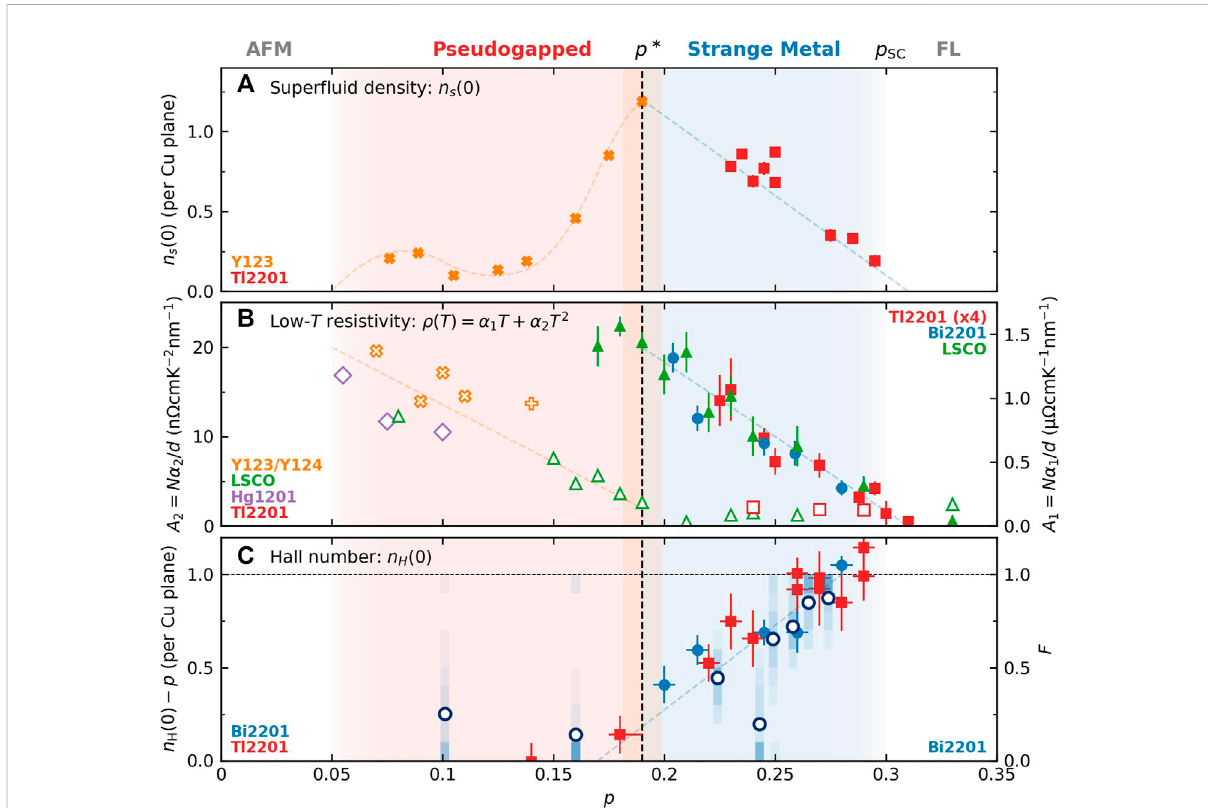
FIGURE 1 Correlations between super fl uid density n s (0) and various transport properties of hole-doped cuprates. (A) Evolution of n s (0) (per Cu) with doping p inY123(orange crosses) and Tl2201(redsquares)obtained frommeasurementsof thezero-temperaturein-planepenetration depth λ ab (0) (summarized in [33, 63]. In order to deduce n s (0) in Y123, we used m * values obtained from high- fi eld quantum oscillation studies over the doping range 0.10 ≤ p ≤ 0.15 [64] and extrapolated to p * = 0.19 assuming that n s (0) approaches 1 + p * there. For a description of how n s (0) is obtained forTl2201,pleaserefertoAppendixAin[33].AllparametersusedinthesedeterminationsarelistedintheSupplementaryMaterial.Notethatthepeak in n s (0)atthepseudogapendpoint p *(verticaldashedline)delineatesthepseudogapped(PG)regime,shadedinorange, fromthestrangemetal (SM) regime, shaded in blue. (B) p -dependence of A 1 = N α 1 / d (right axis, solid points) and A 2 = N α 2 / d (left axis, open points), where d is the c -axis lattice constant, N is the number of CuO 2 planes per unit cell and α 1 , α 2 are coef fi cients of the low- T zero- fi eld resistivity ρ ( T ) = α 1 T + α 2 T 2 . Open crosses (plusses)indicatedataforY123(Y124),respectively.SeeSupplementaryMaterialfortheprecisevaluesandreferencesrelatedtothesedatapoints. (C) Comparison of n H (0) − p , the p -dependence of the as-measured low- T Hall carrier number of Tl2201 and Bi2201 minus its corresponding p value (left axis, closed points [15]) and F , the fractional fi lling of the superconducting gap as measured recently by STM on Bi2201 (right axis, open points [36]). Shaded columns are histograms representing the local variations in the measured fi lling (as in [36]). In each panel, coloured dashed lines are guides to the